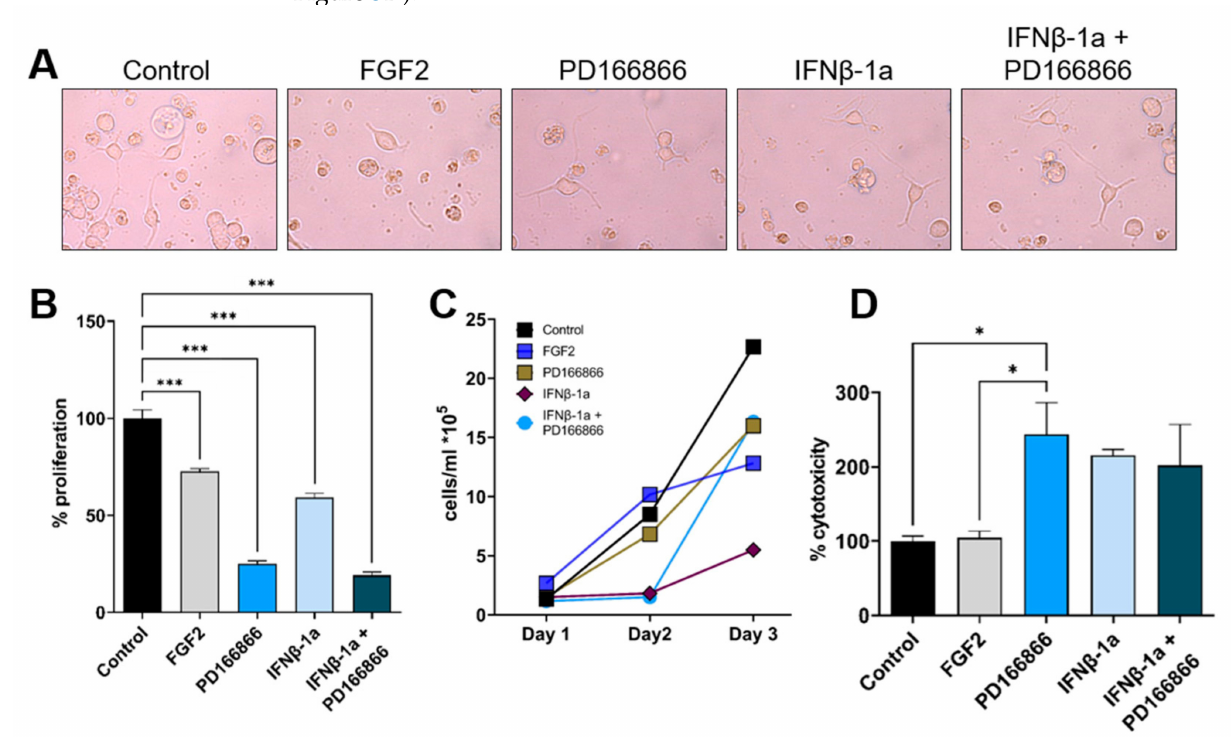
Figure 3. The proliferation and cytotoxicity effects of IFN β -1a and FGFR1 inhibition by PD166866 in oligodendrocytes in vitro. Oli-neu oligodendrocyte cells were incubated for 24 h with cul- ture medium containing FGF2 (20 ng/mL), PD166866 (10 µ M), IFN β -1a (400 ng/mL, Rabiff), IFN β -1a + PD166866. ( A – C ) Proliferation were analyzed by counting the number of cells using light microscopy on day 1, 2, and 3. Cell counting assays showed FGFR1 inhibition by PD166866, IFN β -1a, and IFN β -1a + PD166866 decreases the proliferation of Oli-neu cells. ( D ) LDH cytotoxicity assays showed cytotoxicity effects of FGFR1 inhibition by PD166866. Representative microscopic images of Oli-neu cells under different treatments are shown in 20 × magnification ( A ). Data are presented as mean ± SEM from three independent experiments, * p < 0.05, *** p < 0.001. 2.4. IFN β -1a Treatment along with FGFR1 Inhibition Results in Altered